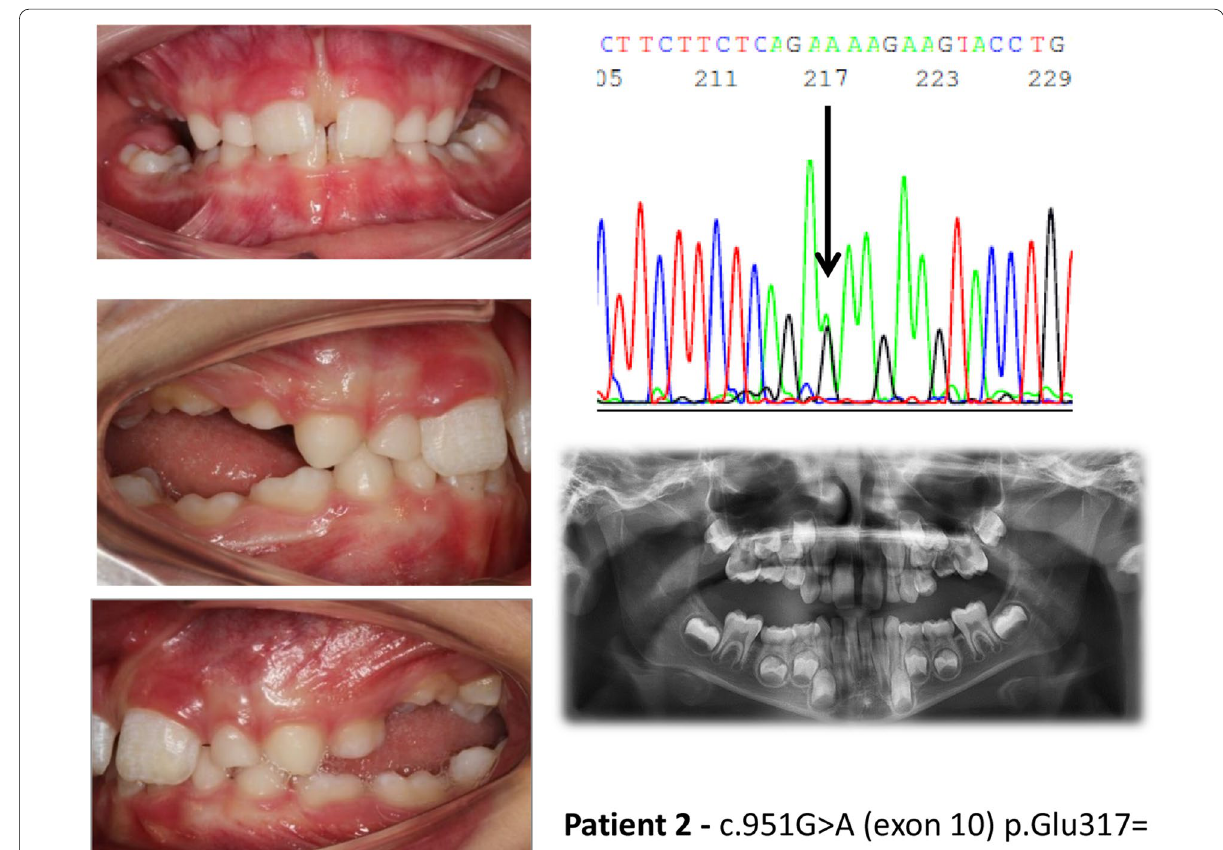
Fig. 3 Clinical features and genetic findings of patient 2 with PFE and a synonymous PTH1R